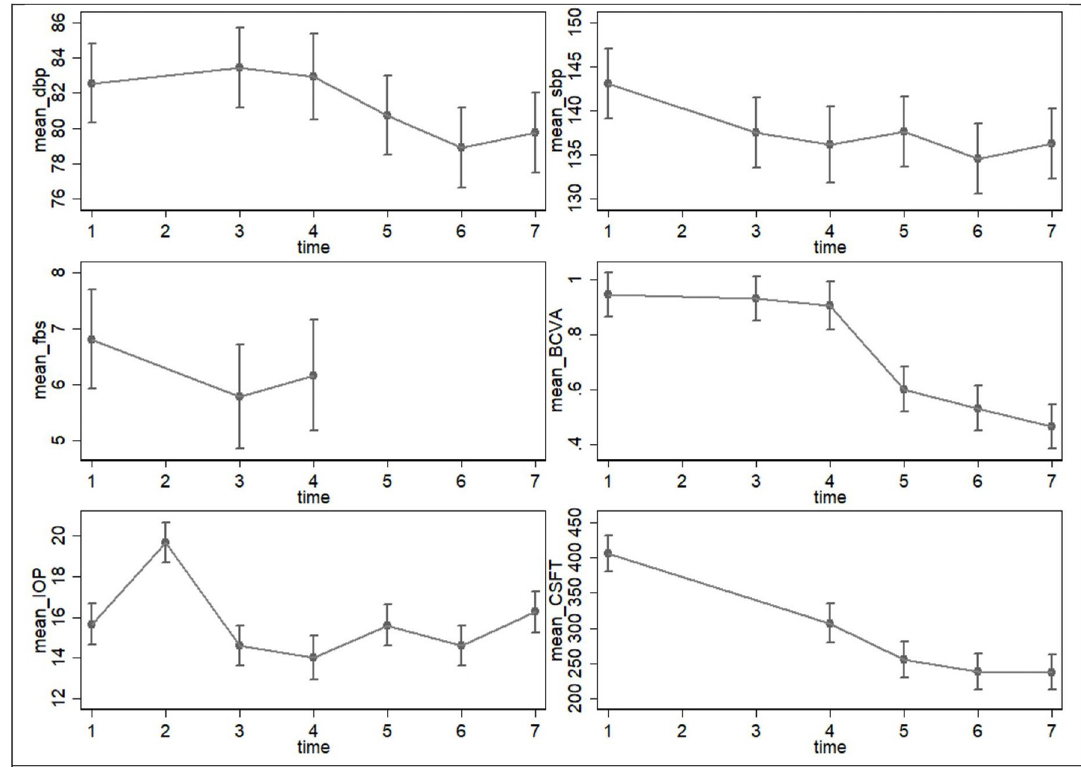
Fig 2. Mean change in clinical parameters over time with 2 standard error margin. 1 = baseline, 2 = 30 minutes post-injection, 3 = day 1, 4 = day 7, 5 = 4 weeks, 6 = 8 weeks, 7 = 12 weeks, BCVA = best corrected visual acuity, CSFT = central sub-field fovea thickness, dbp = diastolic blood pressure, fbs = fasting blood sugar, IOP = intraocular pressure, sbp = systolic blood